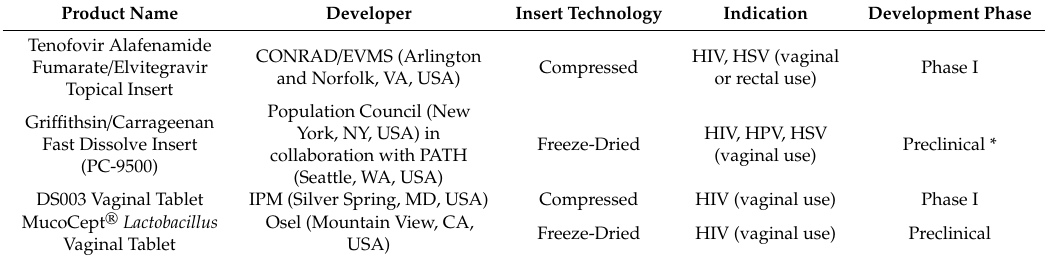
Table 2. Topical inserts in development for HIV or multipurpose HIV prevention.